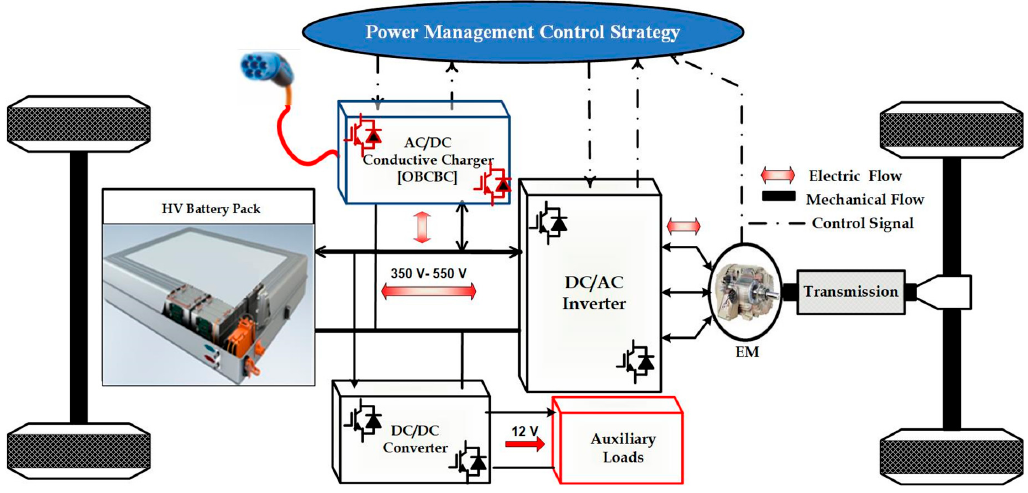
Figure 1. Diagram of the electric vehicle’s components.